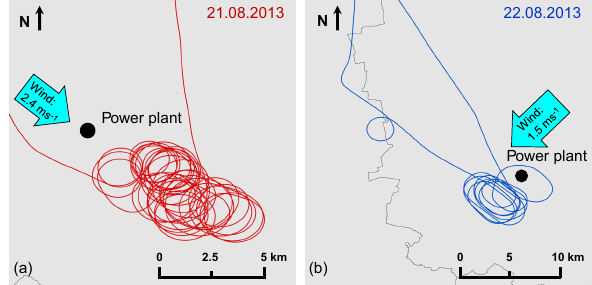
Figure 3. Flight tracks of the ETMEP-2 flights on 21 (a) and 22 (b) August 2013, downwind of the lignite-fired power plant, Lippen- dorf, south of Leipzig, Germany. On both flights the power plant plume was crossed several